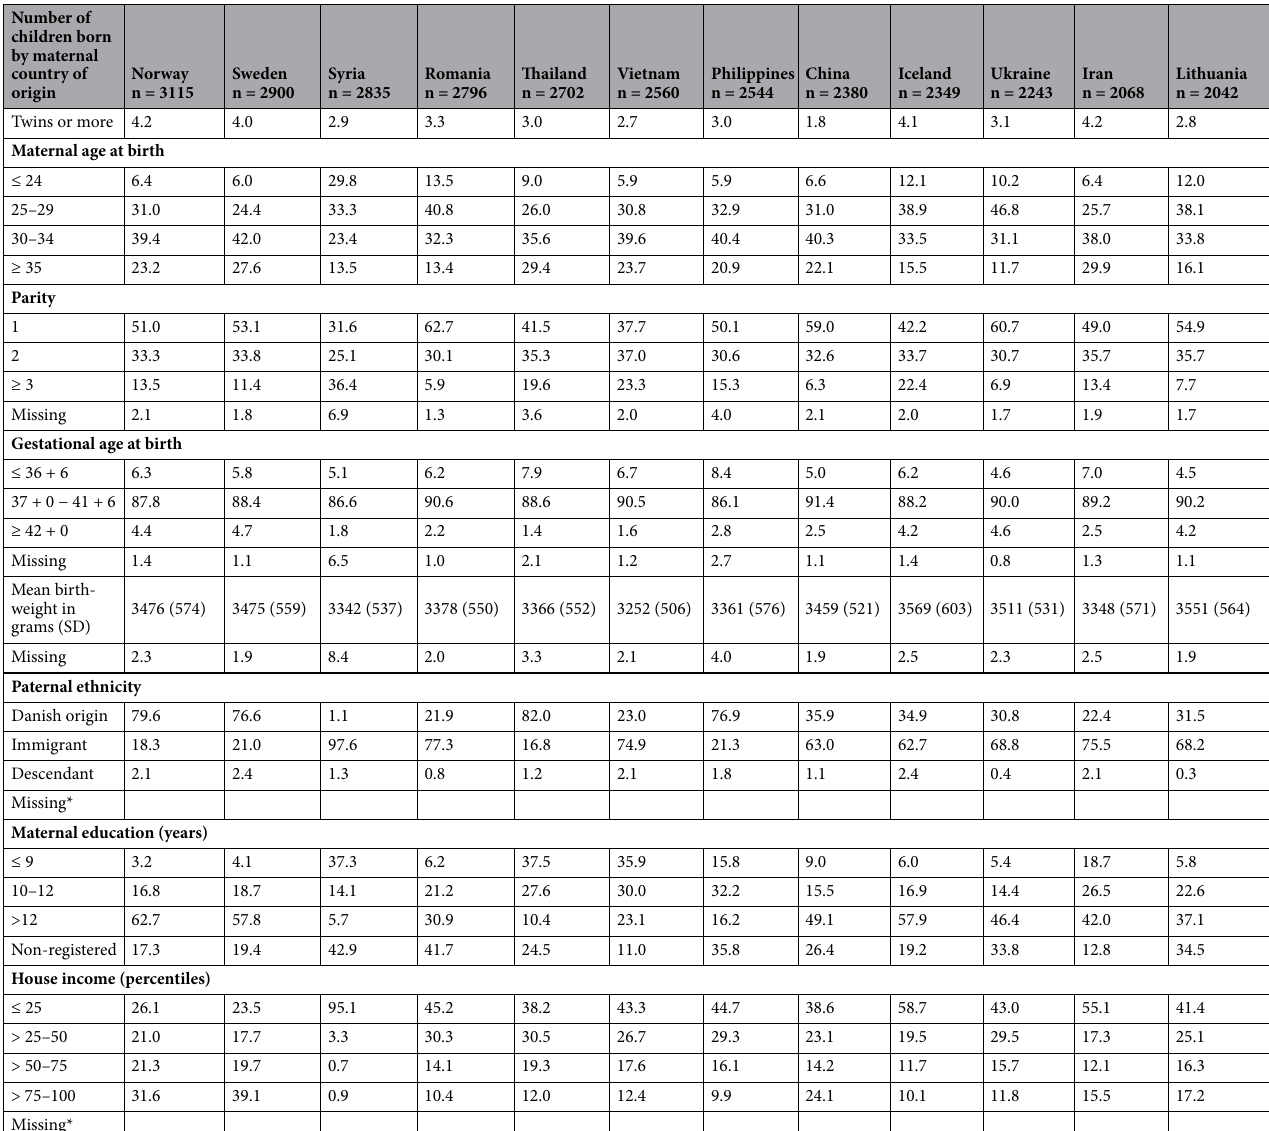
Table 1. Number of children born and distribution of selected characteristics according to maternal country of origin and descent. Births in Denmark 2005–2016. Frequencies are given in percentages and in rounded estimates. *Not listed due to observations < 5 in some cells (missing frequencies is between 0.01– 6.9%). **Include all births to women of Danish origin and to subgroups of immigrants and descendants of immigrants with more than in total 2000 births from